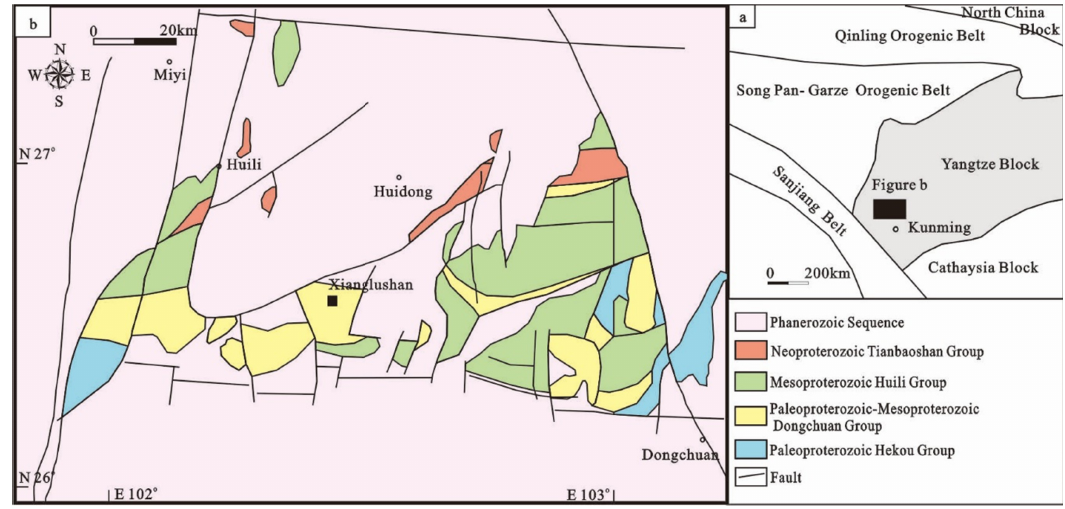
Figure 1. ( a ) Tectonic map of the Yangtze Block; ( b ) Simplified geologic map of the Huili–Dongchuan area (modified from Liu et al.